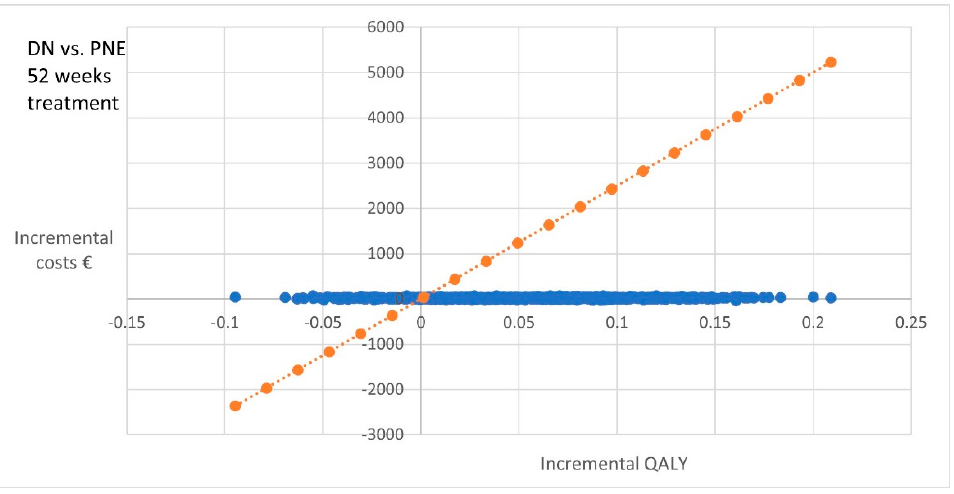
Figure 2. Bootstrapped cost-utility pairs dry needling (DN) vs. percutaneous needle electrolysis (PNE).